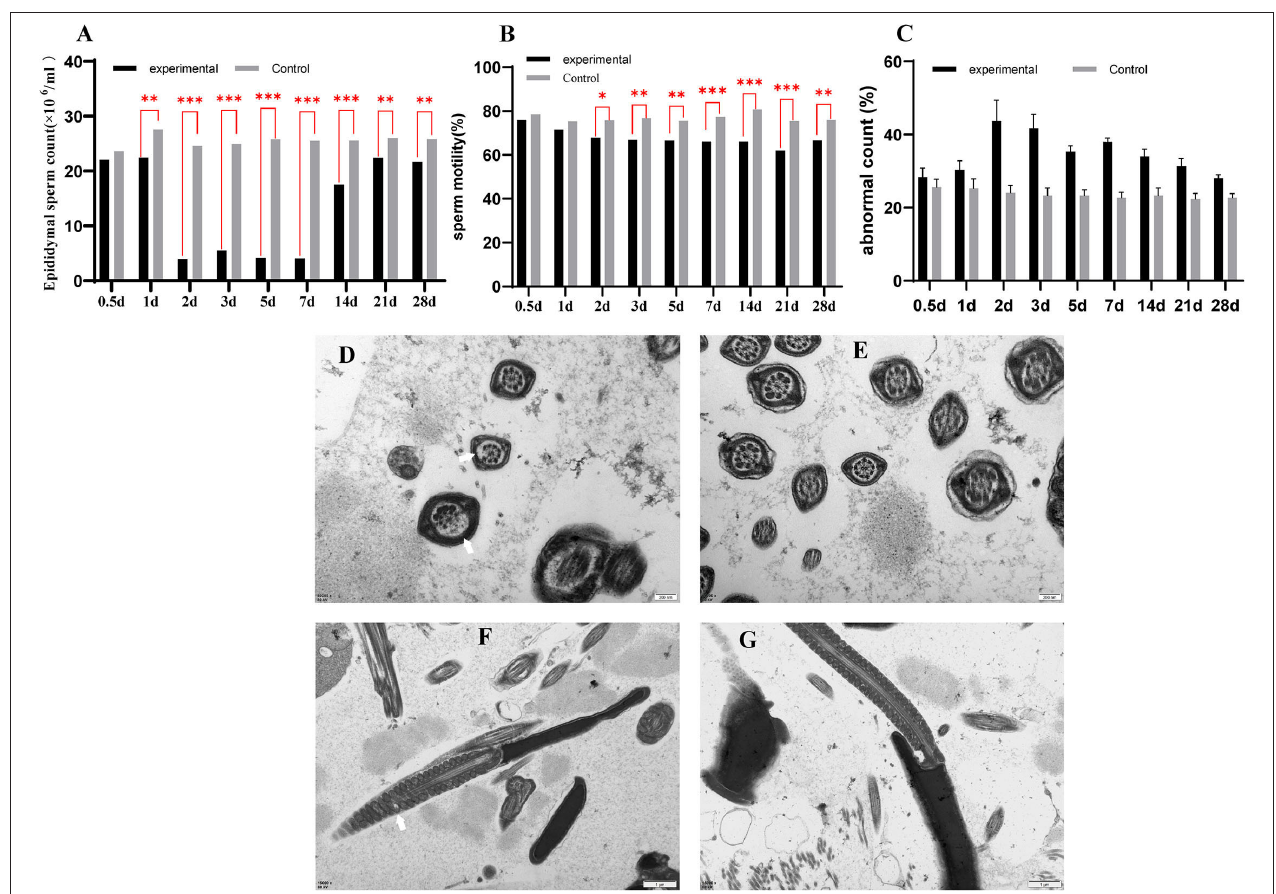
FIGURE 1 | The sperm count of epididymal (A) , the sperm motility of epididymal (B) , the abnormal sperm count of epididymal (C) . A transmission electron microscope photograph of sperm in epididymal (D–G) . (D,F) are transmission electron micrographs of sperm flagellum in a GETV-infected mouse; (E,G) are transmission electron micrographs of sperm flagellum in the control mouse; the scale of (D,E) is 200nm; the scale of (F,G) is 1 µ m. Partial peripheral microtubules disappear (a thin white arrow); swollen mitochondria in sperm midpiece (a thick white